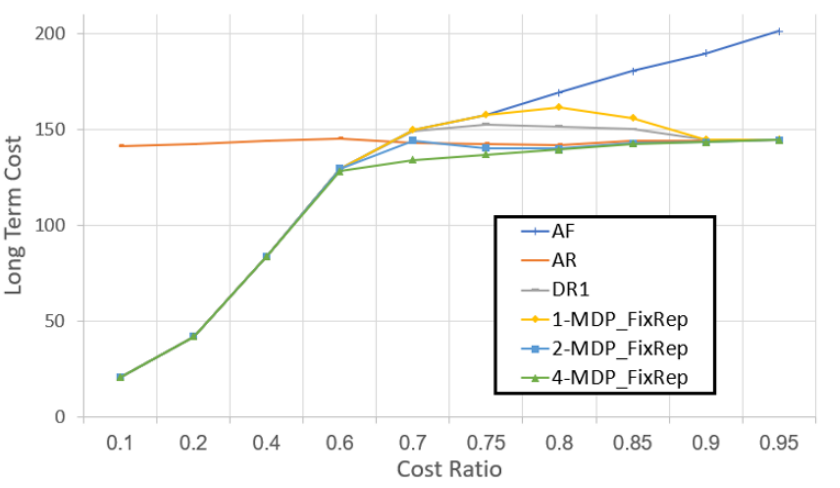
Figure 8. Long-term costs as a function of the cost ratio. Evaluating the N-MDP FixRep